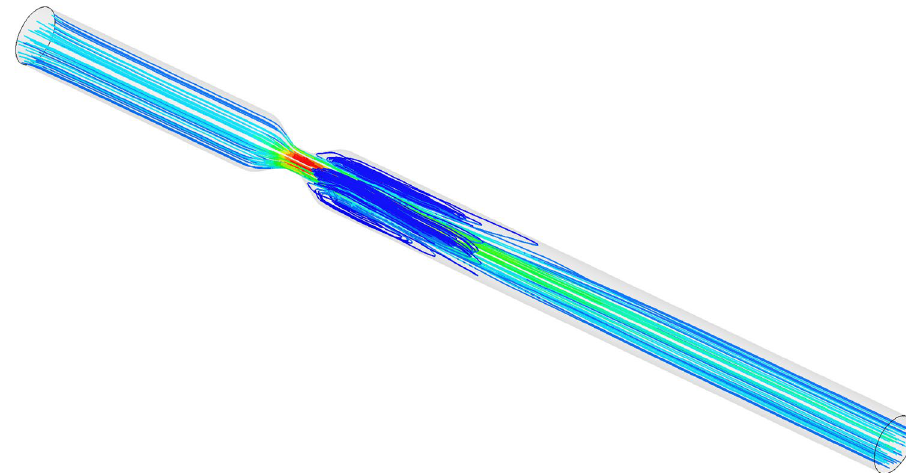
Fig. 8 3D velocity streamlines for case 1 at d/D =